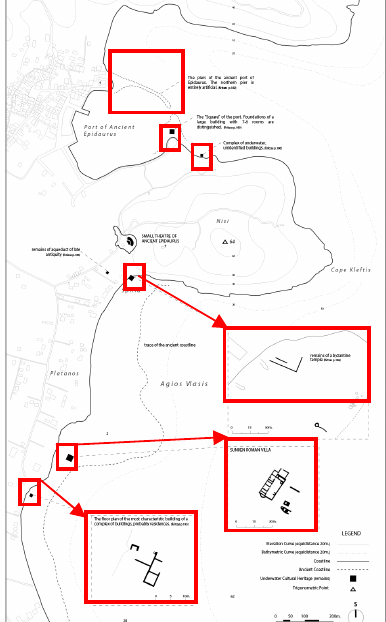
Figure 1. Map of the underwater remains of Ancient